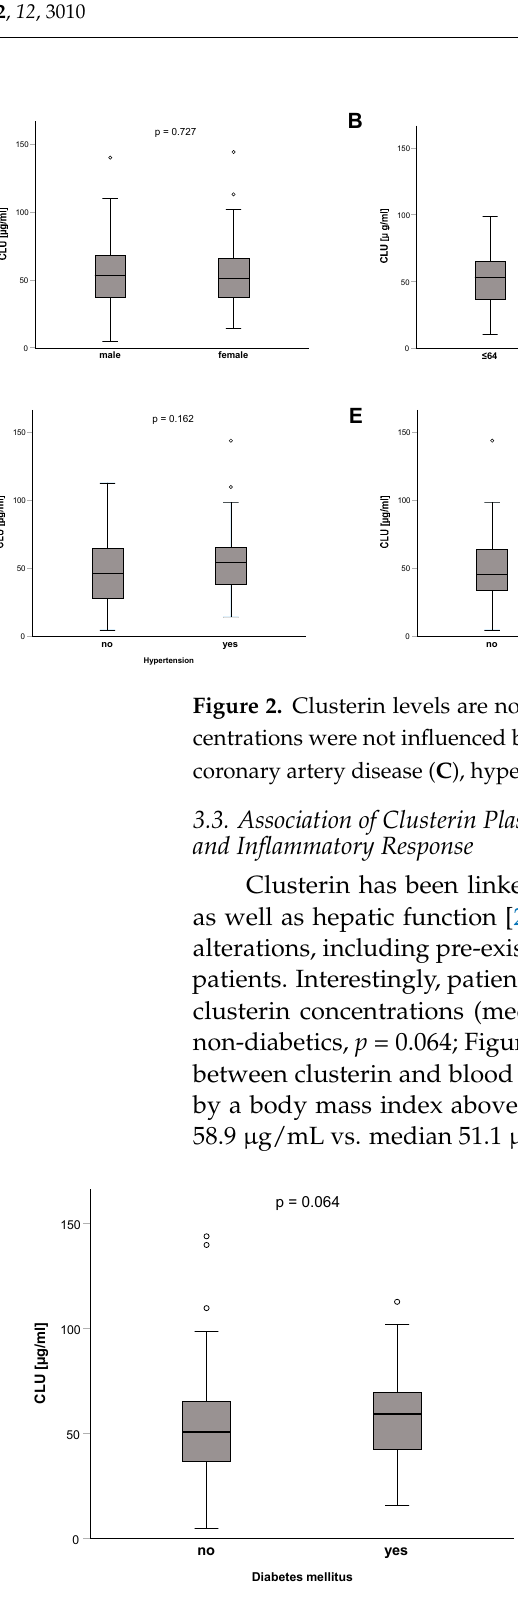
Figure 3. Impact of metabolic comorbidities on clusterin levels. Clusterin plasma concentrations did not differ between ICU patients with or without pre-existing type 2 diabetes ( A ) and obesity, as defined by a body mass index (BMI) above 30 kg/m 2 ( B ). p -values (U-test) are given in the figure. Circle depicts outlier. Table 3. Correlations of laboratory parameters with clusterin plasma concentrations (Spearman rank correlation test; only significant results are shown).